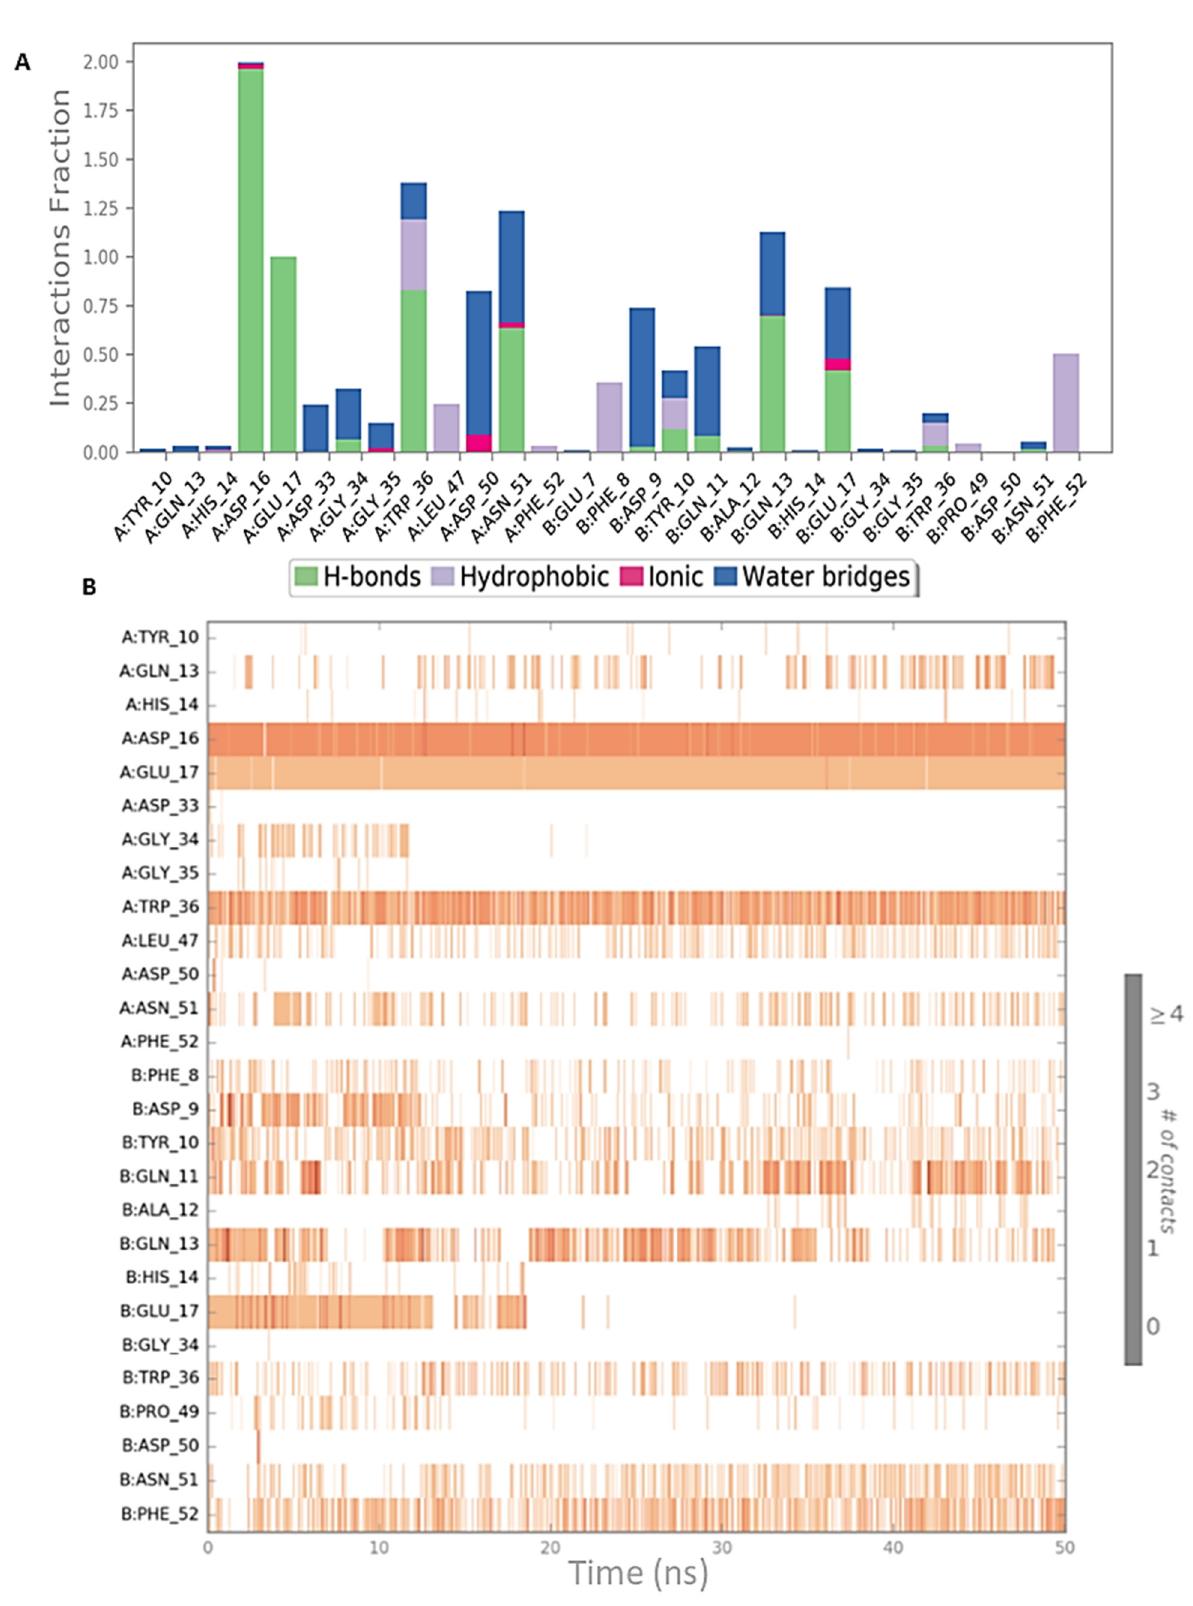
Figure 7. Schematic representations of the interactions occurring in the second MD simulation of CIN85 dimer from PDB 2BZ8 in complex with MUC1 peptide from PDB 5OWP. ( A ) Histogram plot highlighting the CIN85 residues involving in the interactions with MUC1. ( B ) Timeline representations of the interactions during the MD simulation.